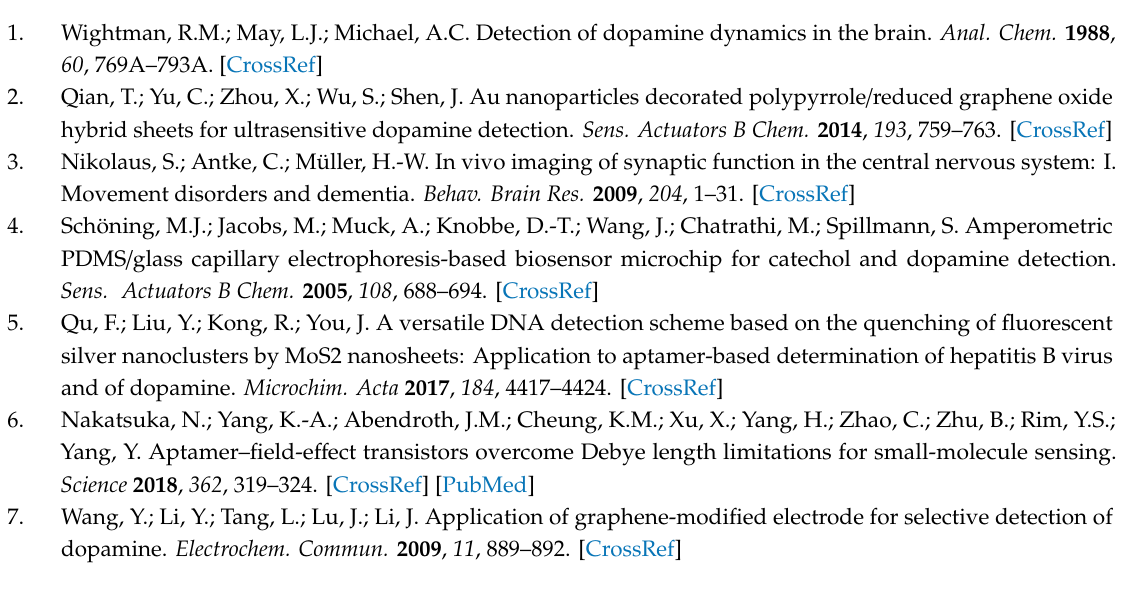
Figure S1: Optimization of the incubation time of amperometric aptasensor with target molecule dopamine (50 µ M), Figure S2: The optimization of operation frequency for SWV measurements at a concentration of dopamine of 30 µ M, Figure S3: The SWV response of amperometric aptasensor to di ff erent concentrations of dopamine without the addition of the aptamer2 molecule, Figure S4: The output and transfer characteristics of iOECTs by using a gold electrode as the gate electrode, Figure S5: The photograph of aptamer-modified gold electrode integrated with flexible iOECTs, Figure S6: The variation of source–drain current with time measured in 10 mM Tris bu ff er at applied V ds = − 0.05 V and V gs = 0.35 V, Table S1: The gate potential ( V gs ) and corresponding potential change ∆ V gs (mV) at I ds / I ds,on = 0.5 of transfer characteristics of an iOECT chip at di ff erent dopamine